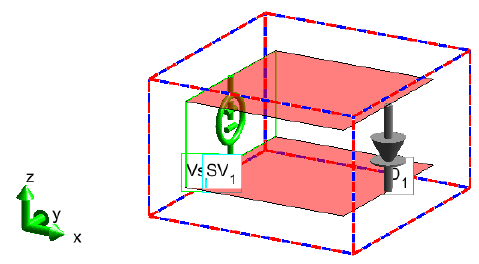
Figure 4. Voltage source with terminal